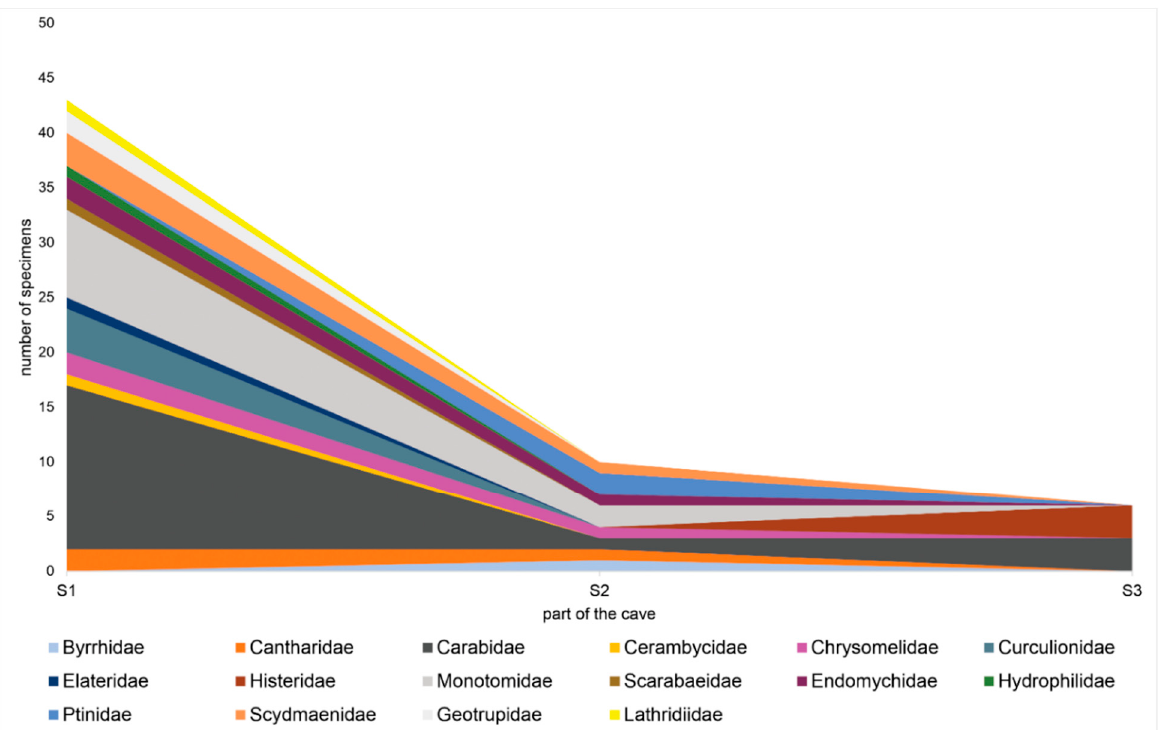
Figure 6. Distribution of beetles inside the caves; richness in particular parts of the caves is shown for beetle families, except the three most numerous (Staphylinidae, Leiodidae, Cryptophagidae). Table 1. Number of species recorded in particular parts of studied caves. S0–S5—sampling sites.